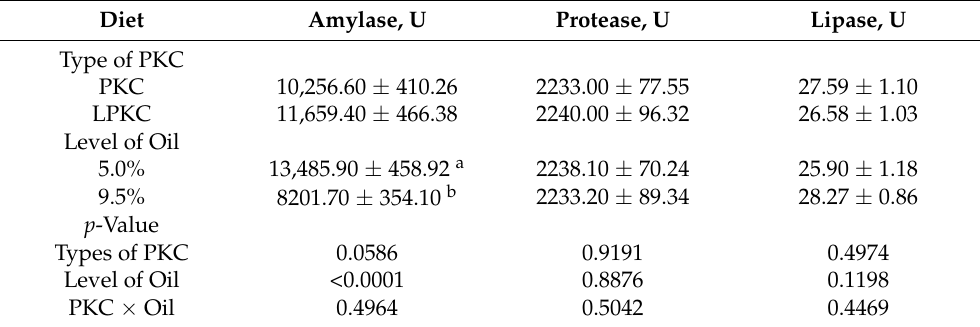
Table 5. Effect of type of PKC and level of oil on digestive enzyme activities in the intestinal contents (Mean ±